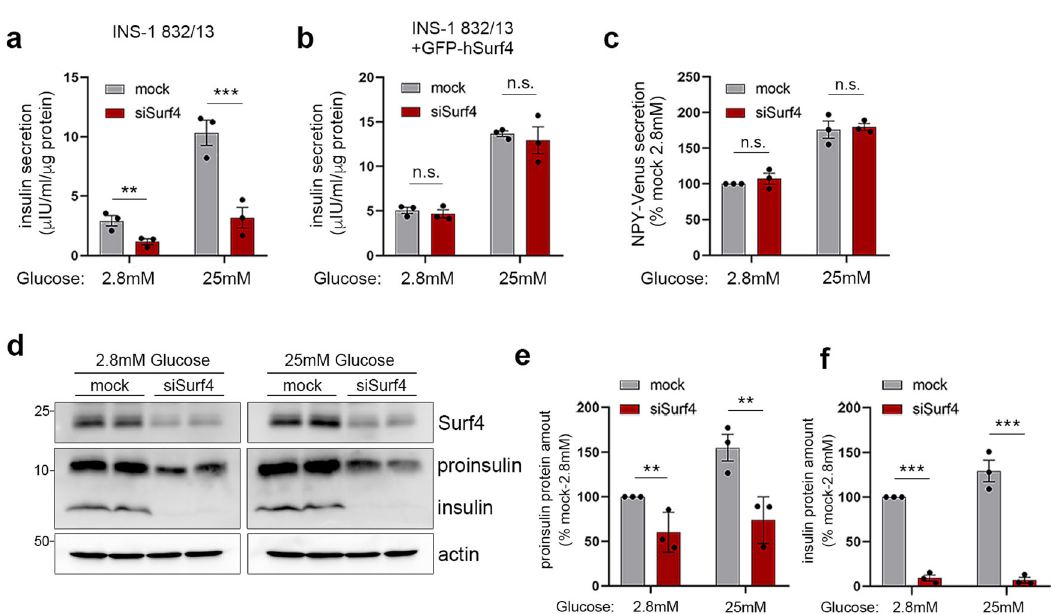
Fig. 2 Surf4 is required for insulin secretion. a , b INS-1 832/13 cells ( a ) or INS-1 832/13 cells stably expressing GFP-hSurf4 ( b ) were transfected with siRNA against non-target control (mock) or rat Surf4 (siSurf4) and incubated with KRB containing low (2.8 mM) or high (25 mM) glucose for 2 h. The amount of secreted insulin was measured ( n = 3). c INS-1 832/13 cells stably expressing a neuropeptide Y (NPY)-Venus were treated with mock- or Surf4- siRNA and incubated at low- or high-glucose conditions. The amount of secreted NPY-Venus was measured ( n = 3). d Whole-cell lysates of INS-1 832/13 incubated at low- or high-glucose conditions were subjected to immunoblotting analysis using an anti-insulin antibody that recognizes both proinsulin and insulin and anti-Surf4, anti- β -actin antibodies. e , f Proinsulin and insulin levels in ( d ) were quanti fi ed by densitometric scanning of band intensities, and their relative amounts were calculated ( n = 3). Data are presented as the mean ± standard error of the mean and analyzed by two-tailed unpaired Student ’ s t -tests ( a – c , e , f ), ** p < 0.05; *** p < 0.01; n.s. not signi fi